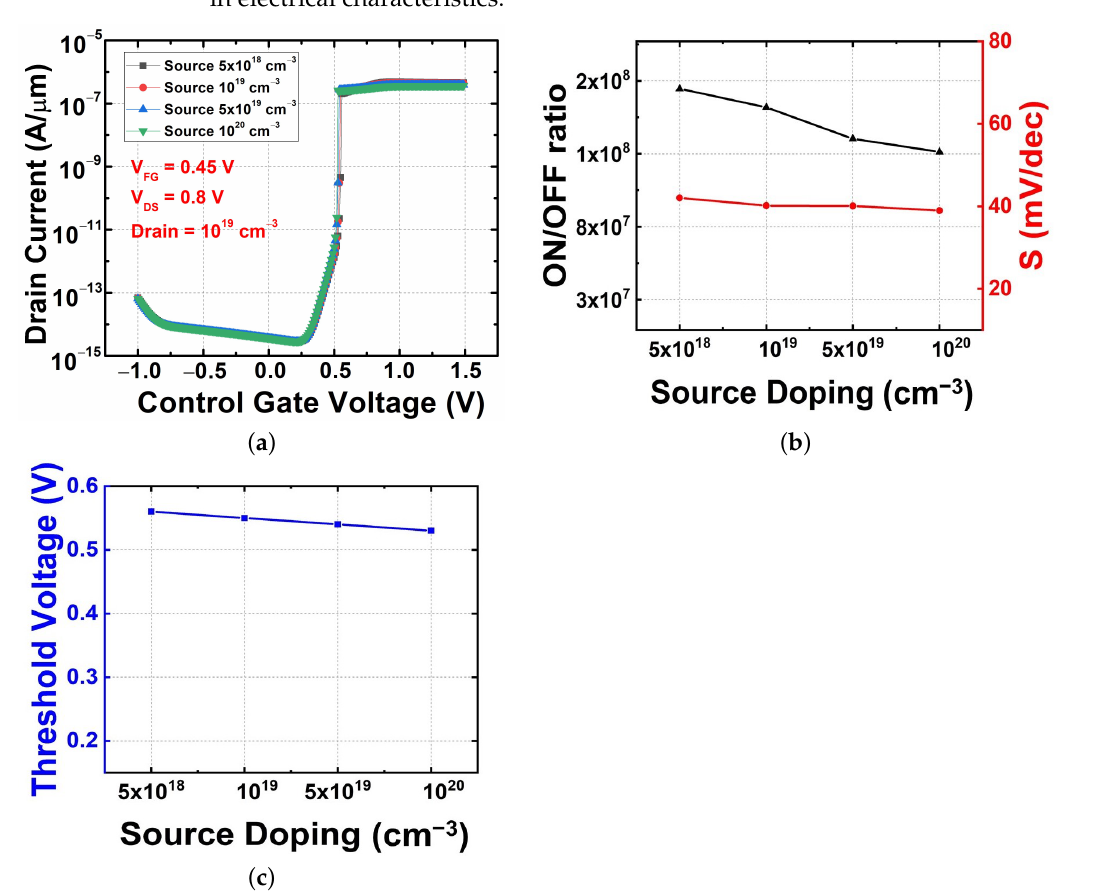
Figure 5. Electrical characteristics with source doping variations. ( a ) Transfer characteristics, ( b ) on– off current ratio and subthreshold swing, and ( c ) threshold